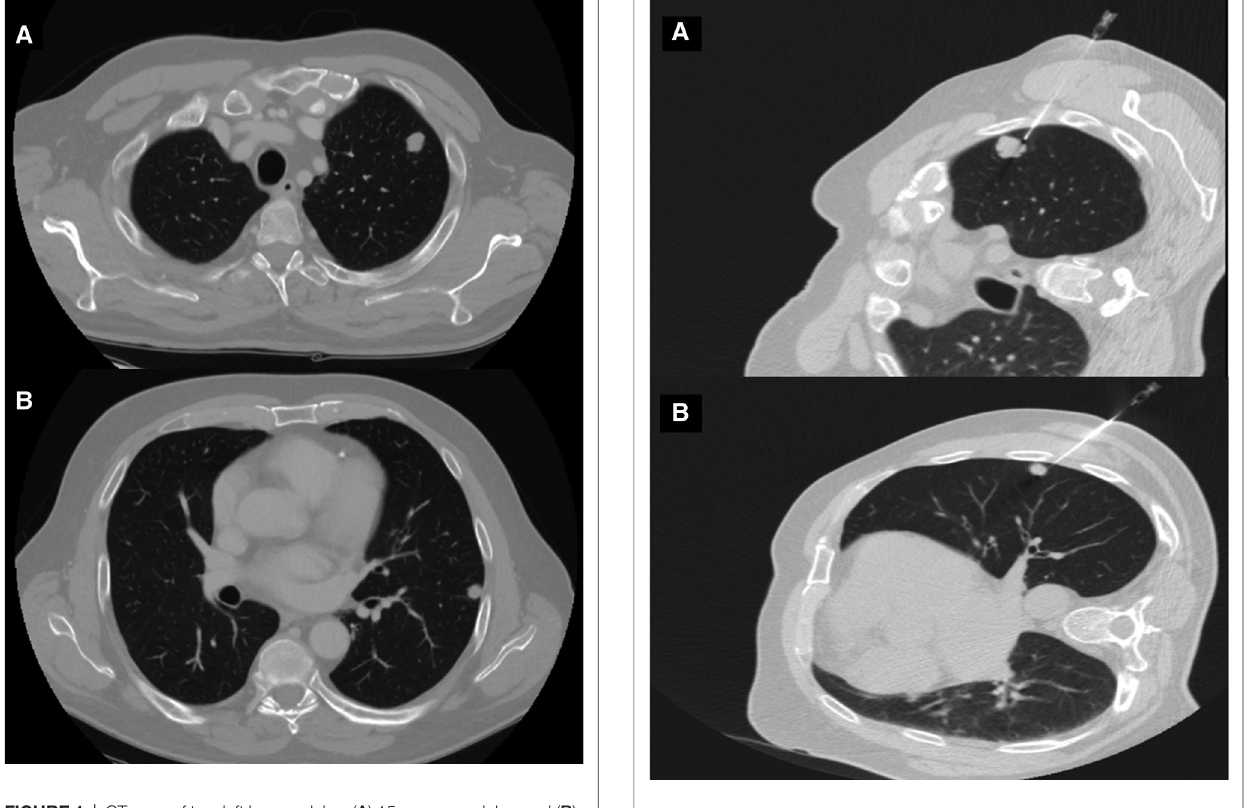
FIGURE 2 | CT scan of needle injection of indocyanine green.